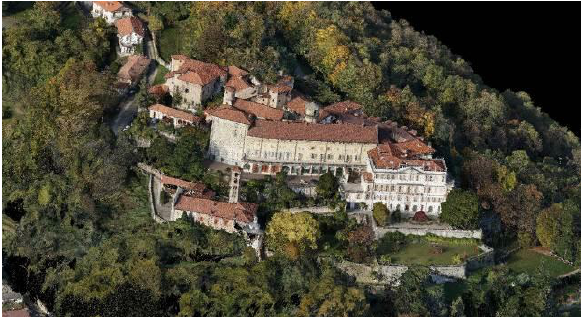
Figure 11. (side column) The 0.212 km 2 extension of the orthophoto Figure 9. Two different bird eye views of the processed dense covering area, projected on regional DEM. (Nany Matamoros elab.); cloud. (18 milion points) (above) An excerpt of the 2 cm resolution orthophoto, enabling to examine a collapsed